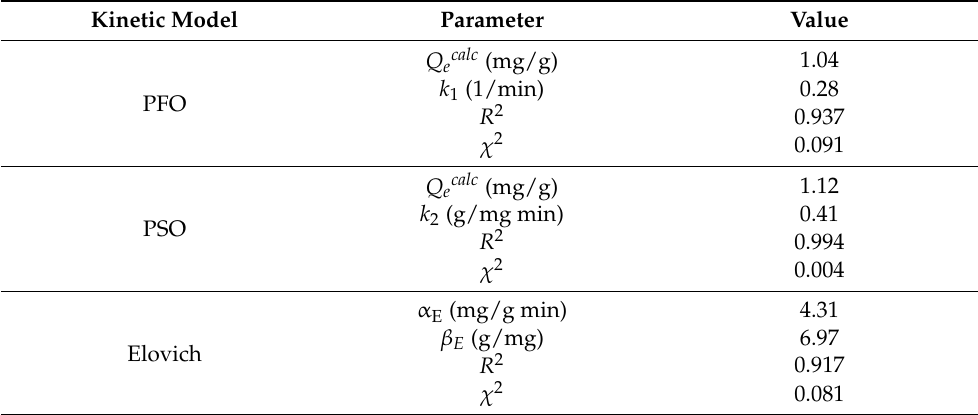
Figure 6. Nonlinear fitting curves for the kinetics sorption of chromium on Fe 3 O 4 @APTMS/PGME- deta sorbent. Error bars represent the standard error of three replicates. Table 1. Kinetic parameters of the chromium sorption onto Fe 3 O 4